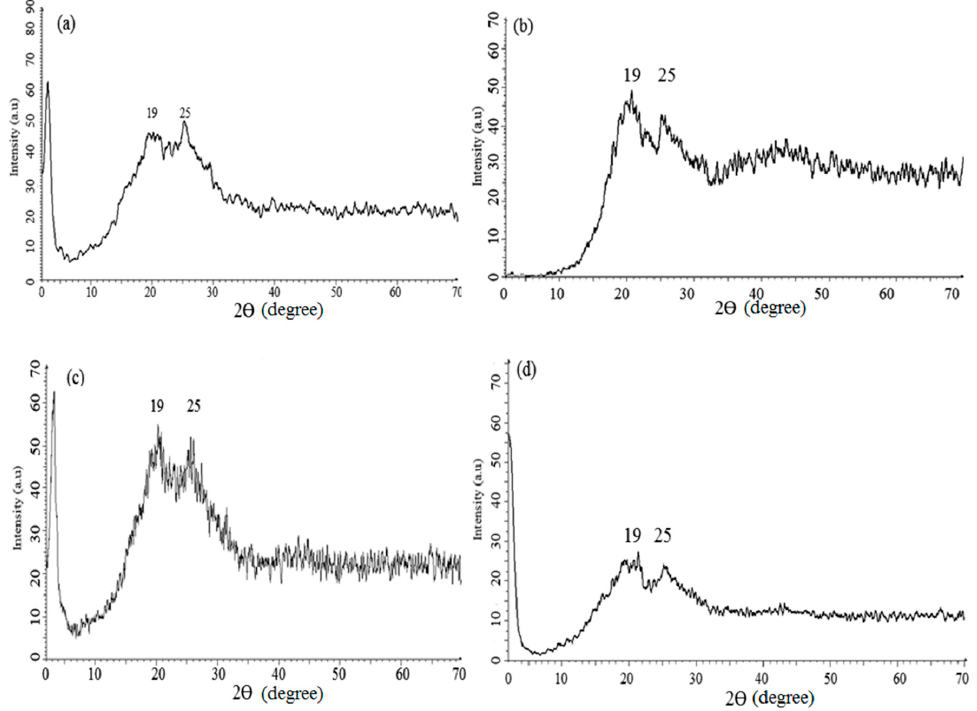
Figure 8. X-ray diffractograms of ( a ) PANI A4 ( b ) PANI B9 ( c ) PANI D2 ( d ) PANI S3.